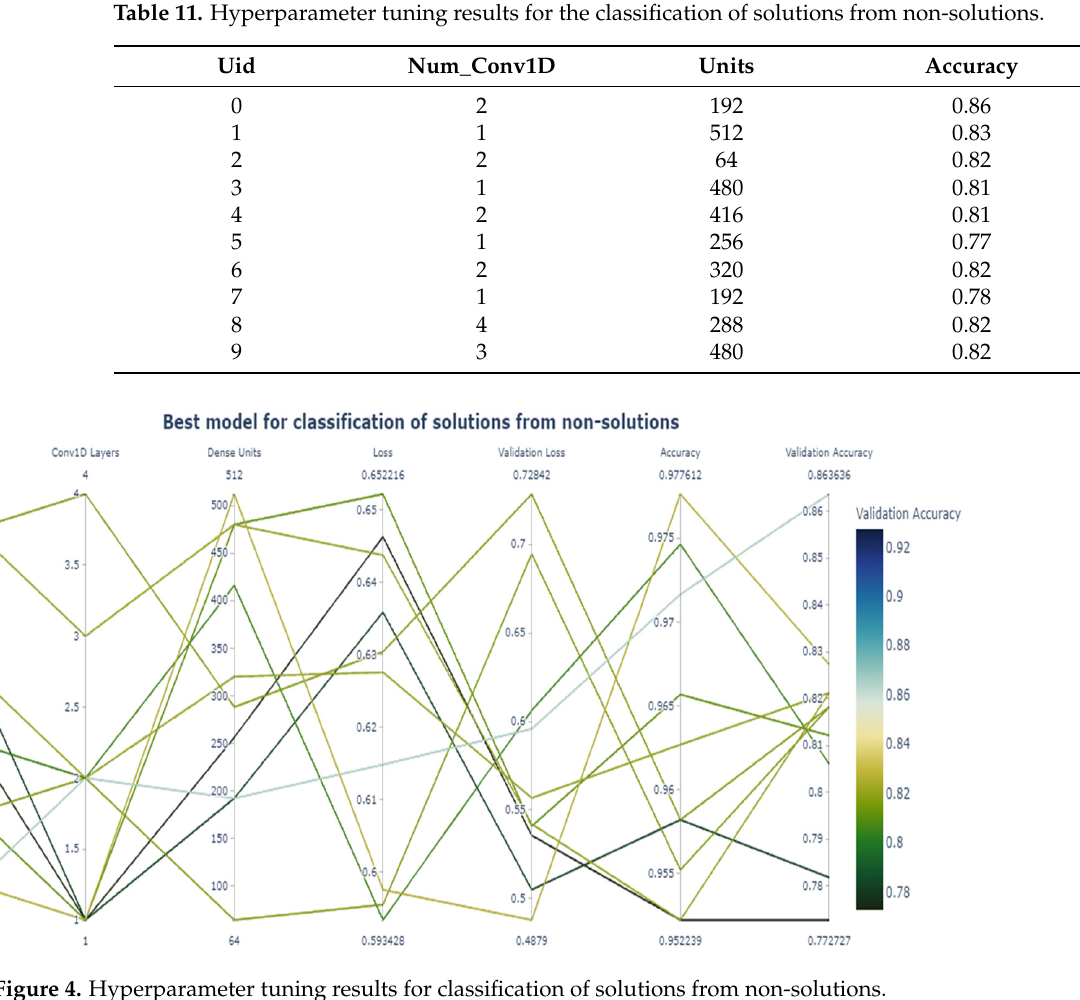
Table 12. Best performing CNN